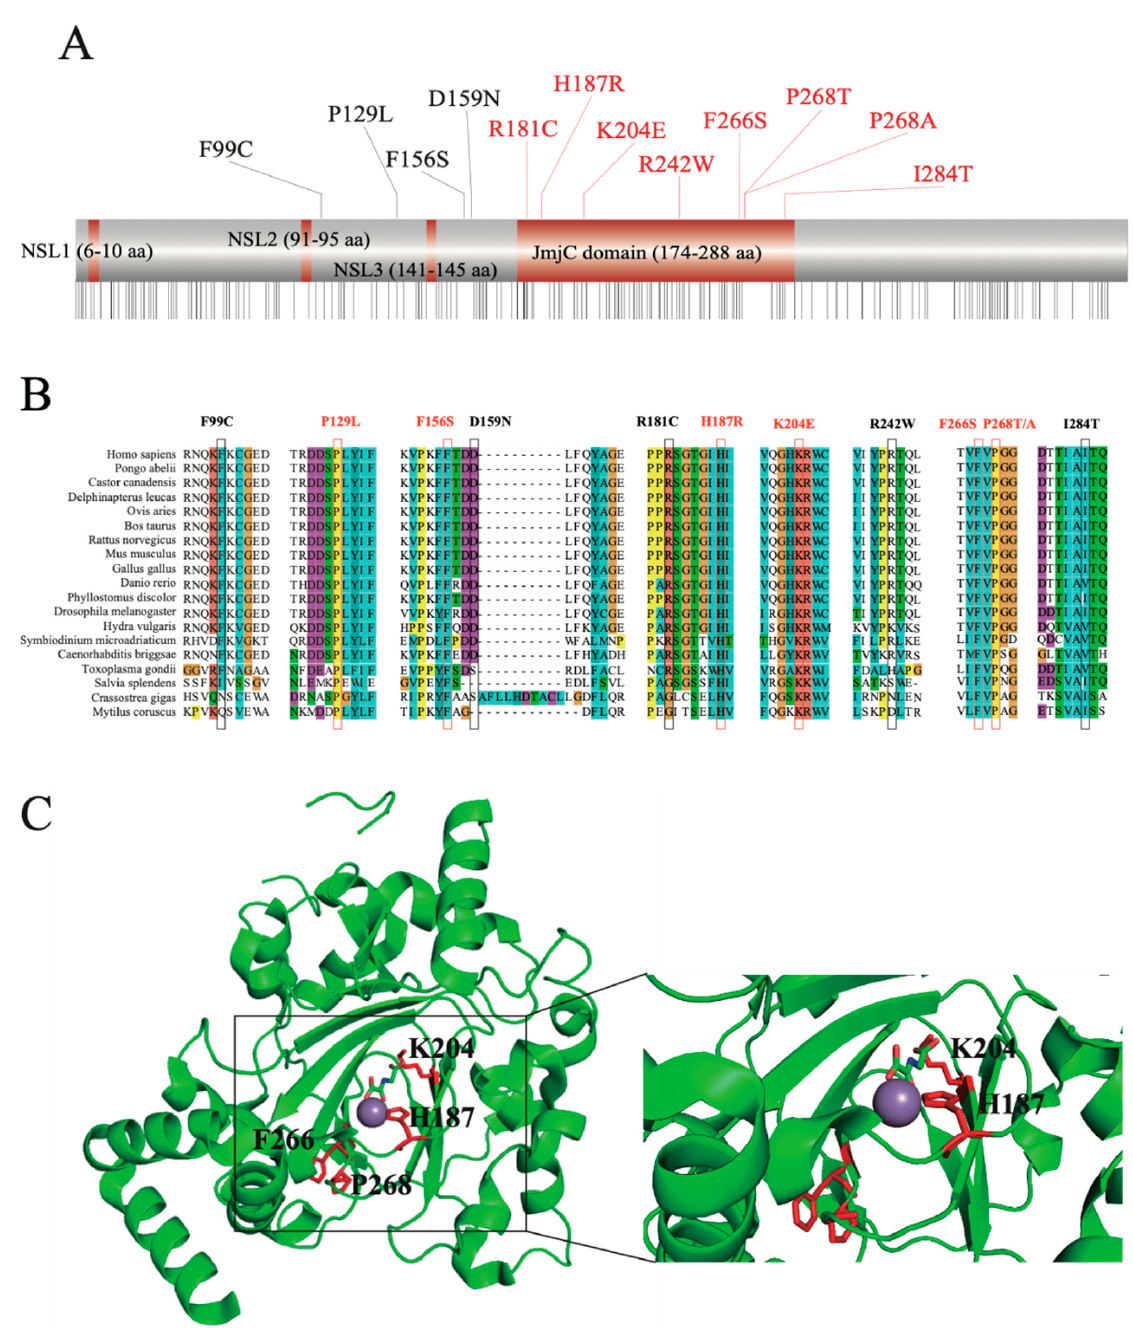
Figure 2. Protein homology and structural features. ( A ) Schematic representation of the JMJD6 protein. Eight mutations located at the JmjC domain (174-288 aa). ( B ) Multiple sequence alignment of the JMJD6 protein. Different colors represent different amino acids. Highly conserved mutation sites (consensus score > 90) are labeled in red (P129, F156, H187, K204, F266, and P268). ( C ) Crystal structure of JMJD6. H187 and K204 are located in the JMJD6 enzyme activity region, and H187 is the nearest site to the enzyme activity center. The purple ball represents Fe(II).